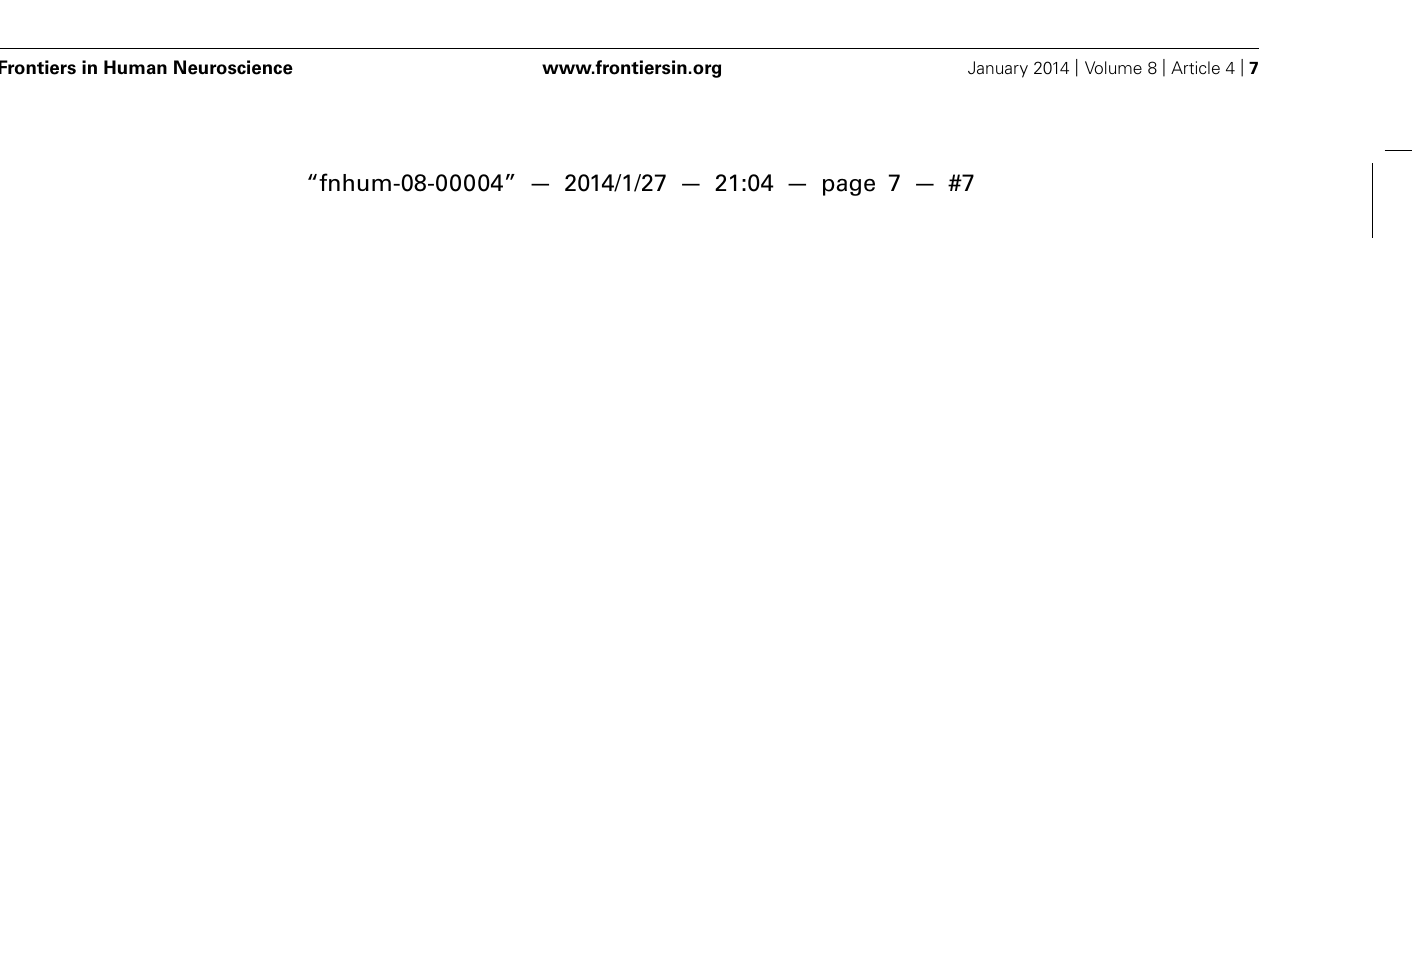
FIGURE 4 | Component (C1). (A) Component waveform. Green boxes represent the time windows used for statistical analysis. (B) Topographic map showing voltage distribution of C1. Orientation is top looking down with nose at the top. Positive voltage values are red and negative values are blue, with the zero crossing in white. Dots on the map are channel locations and white dot represents channel used for the waveform in (A) . (C) Source results projected onto a schematic flat map (unfolded cortex) to show activity at all cortical sites. The area within the white border